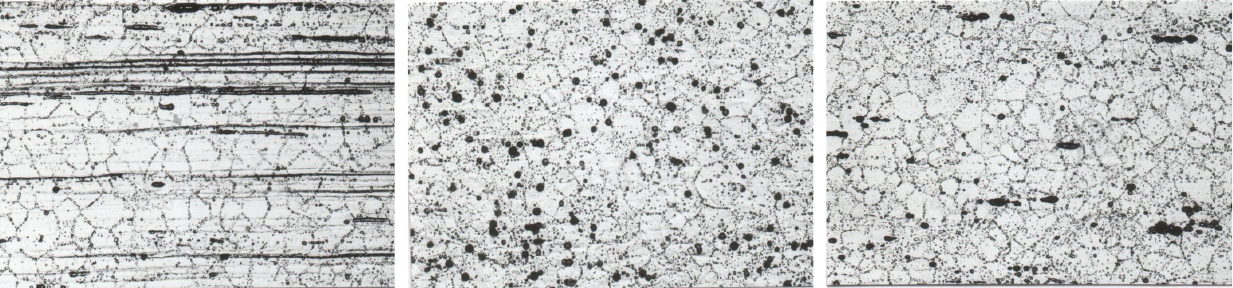
Figure 3b: “5” steel microstructure - Transversal section (x 200).